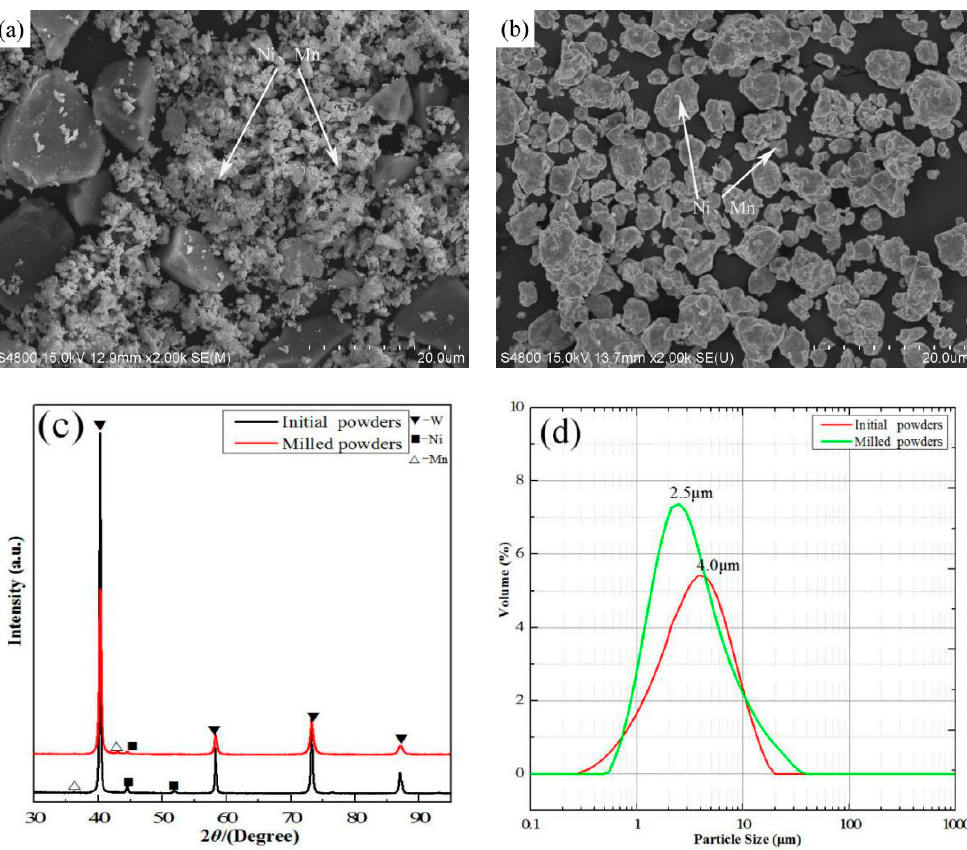
Figure 1. The characterization of W-6Ni-4Mn composite powders: ( a ) starting powders, ( b ) after mechanical alloying, ( c ) XRD patterns, and ( d ) particle size distribution curves.